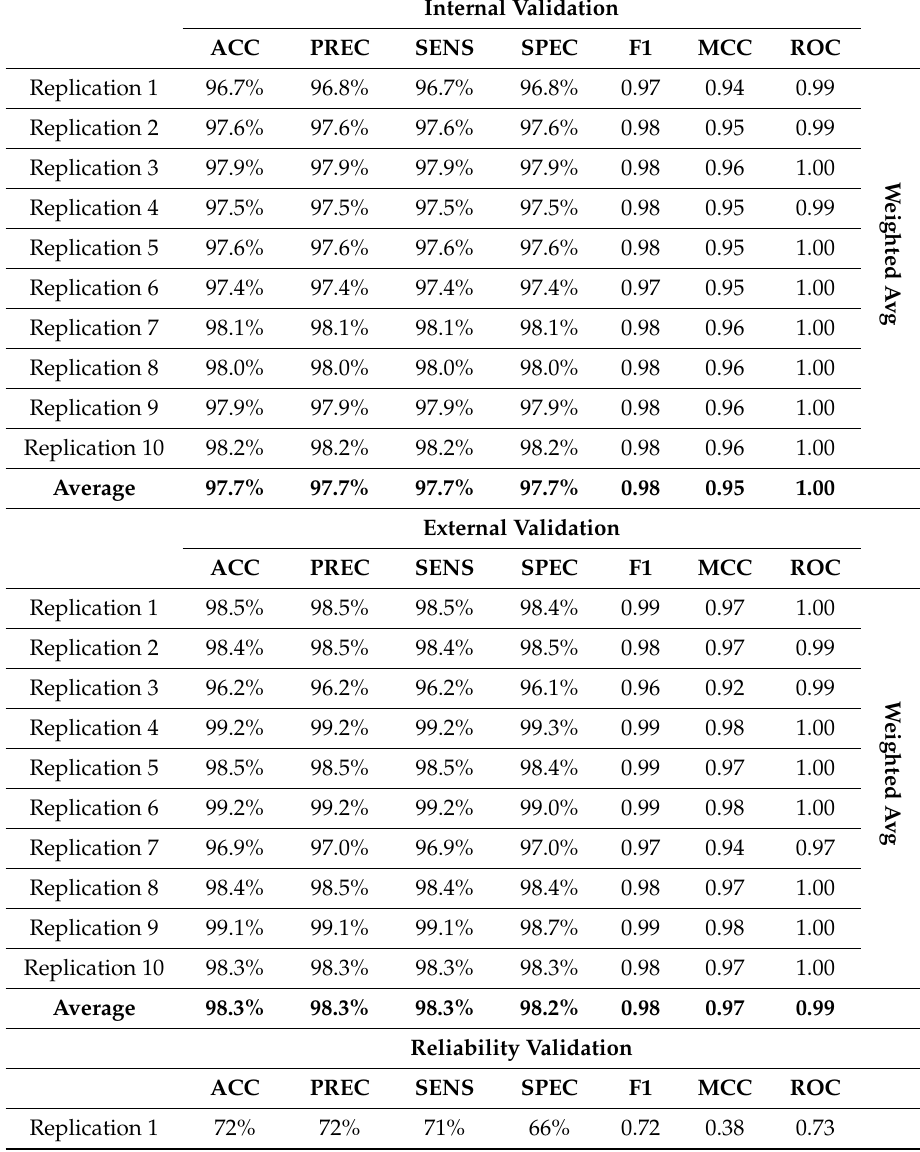
Table 3. Internal 10-fold cross validation model performance and external validation-predictivity for the ten random samples of the